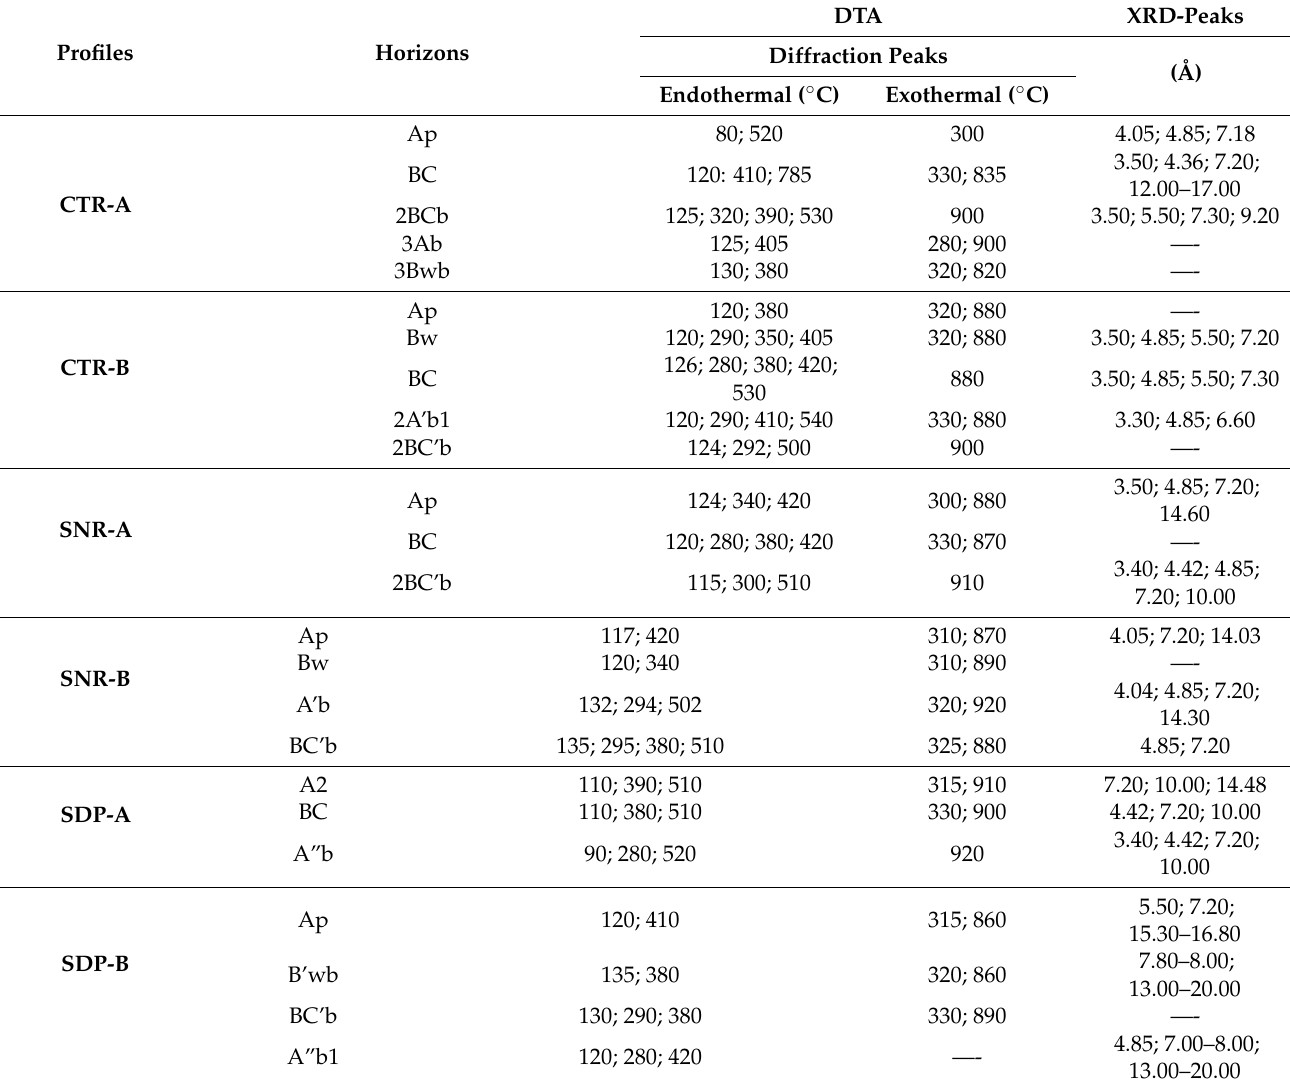
Table 4. Differential Thermal and X-Ray Diffraction Analyses of soils from different agro-climatic zones, of different types, and with different ages of parent